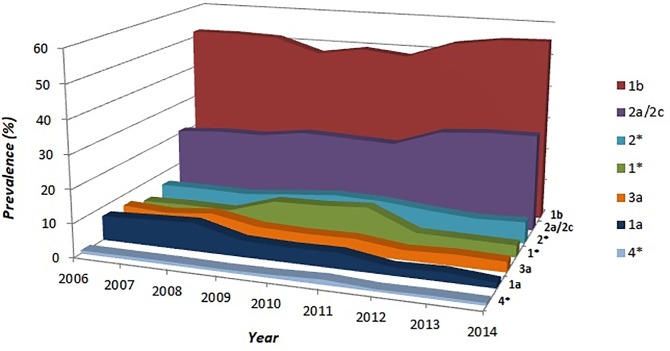
Distribution of HCV genotypes from 2006 to 2014.